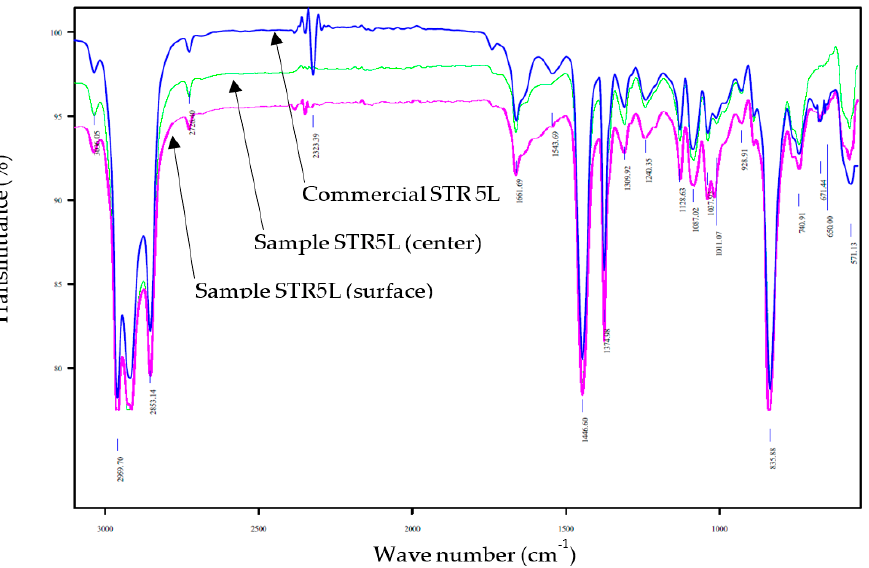
Figure 10. Examination of the chemical structure for STR 5L using the attenuated total reflection Fourier transform infrared spectroscopy (ATR-FTIR) technique compared to commercial hot air dried rubber.